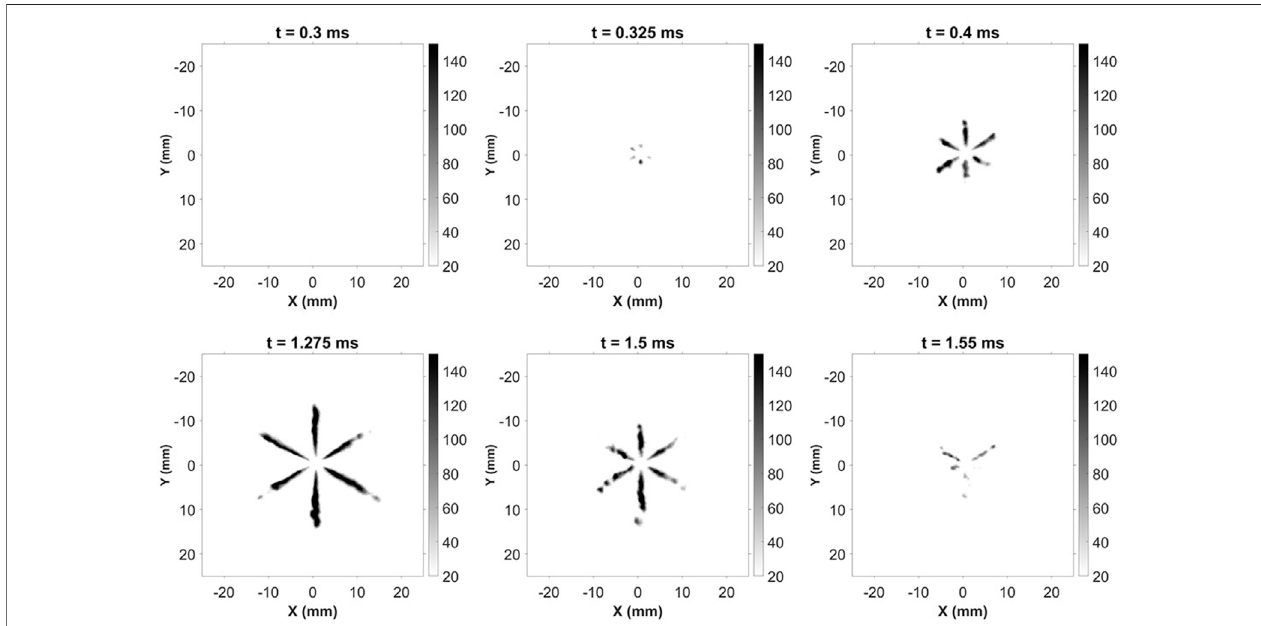
FIGURE 6 | Liquid penetration imaging from high-speed Mie-scattering technique performed under inert conditions in a constant volume combustion chamber (CVCC). Test conditions: Rail pressure, 1500 bar; ET, 1 ms; ambient density, 50.8 kg/m 3 ; ambient temperature, 1000 K; frame rate, 40 kHz (time is referenced to the start of ET).